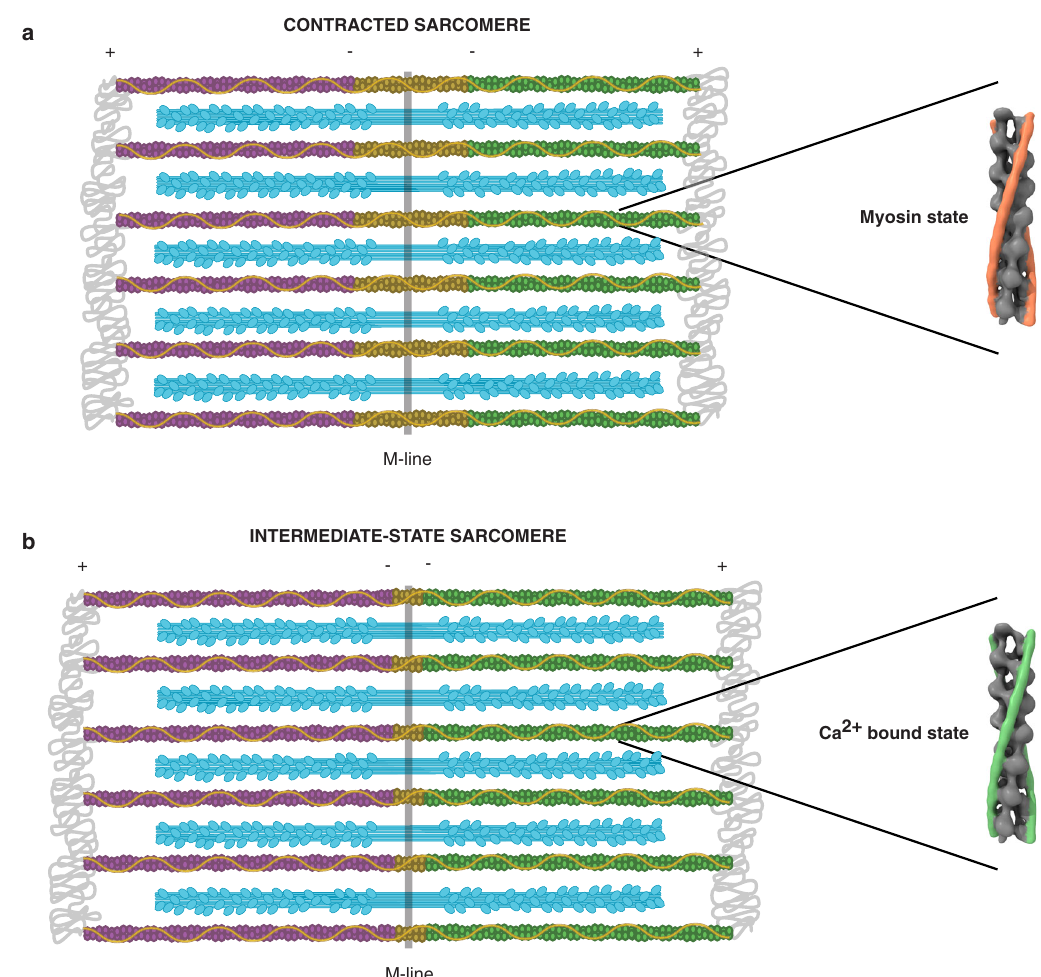
Fig. 6 Thin fi lament organization during sarcomere contraction in neonatal cardiomyocytes. a Contracted sarcomeres in which thin fi laments are strongly bound to thick fi laments, exhibit an overlap between thin fi laments of opposite polarity beyond the bare zone region. b When the actomyosin interaction is weaker, sarcomeres are found in an intermediate state in which thin fi laments of opposite polarity barely